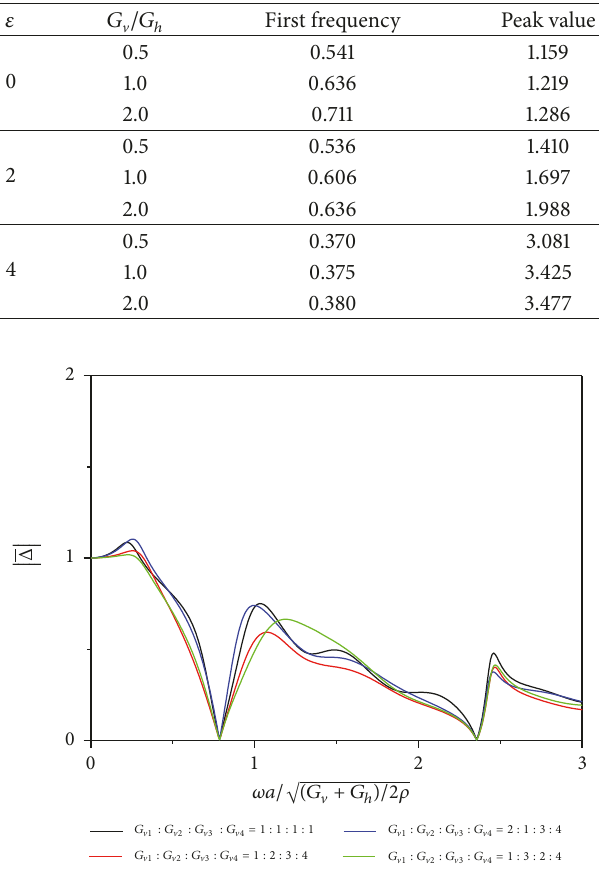
Table 1: Numerical results of effective input motion for 𝐷/𝑎 = 2 and 𝑀 /𝑀 = 1 . 𝑏 0